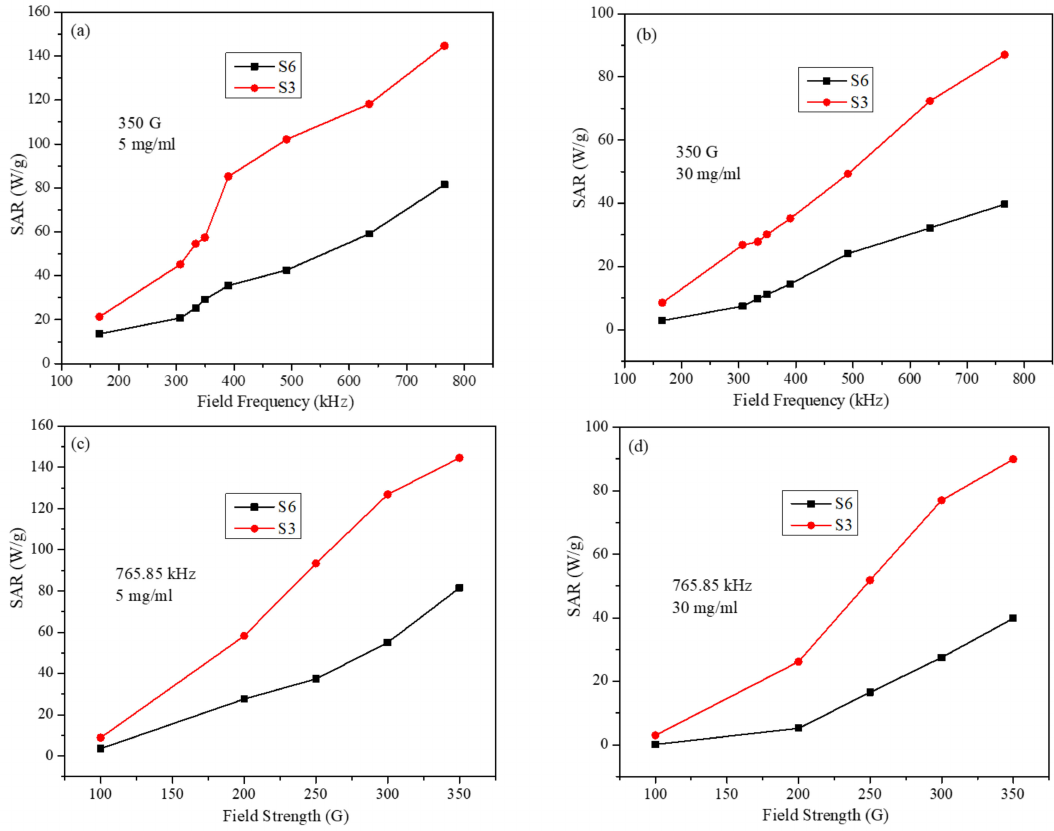
Figure 8. SAR values for S3 and S6 samples ( a ) at fixed field strength, at 5 mg/mL concentration, ( b ) at fixed field strength, at 30 mg/mL concentration, ( c ) at fixed field frequency, at 5 mg/mL, and ( d ) at fixed field frequency, at 30 mg/mL (lines in figures are just to guide the